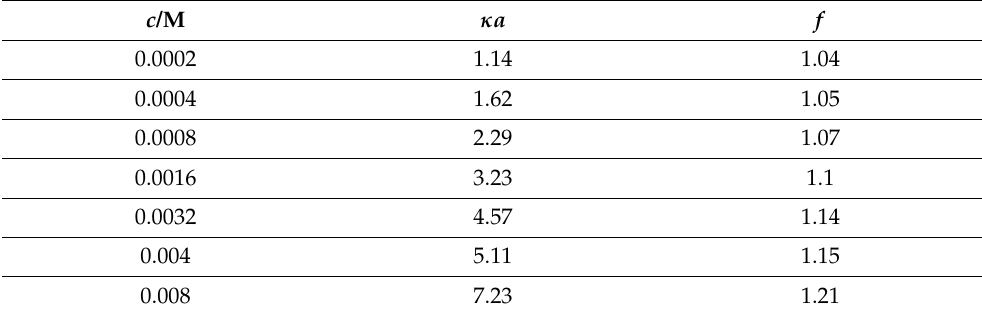
Table 2. The κ a and f in typical dispersions used in this study. Both κ a and f are dimensionless. c /M